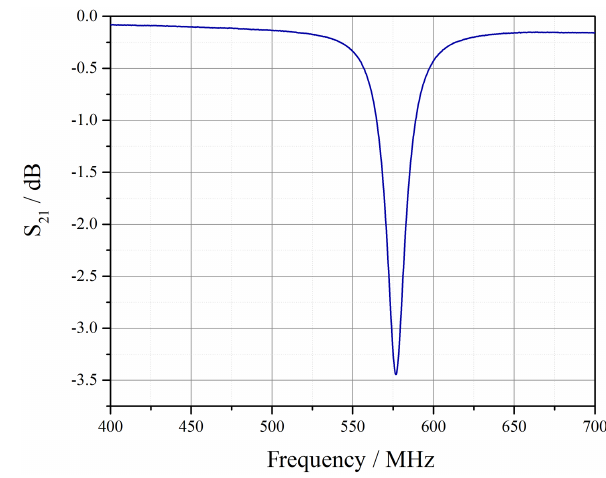
Figure 2. Transmission measurement of the unloaded split-ring res- onator.